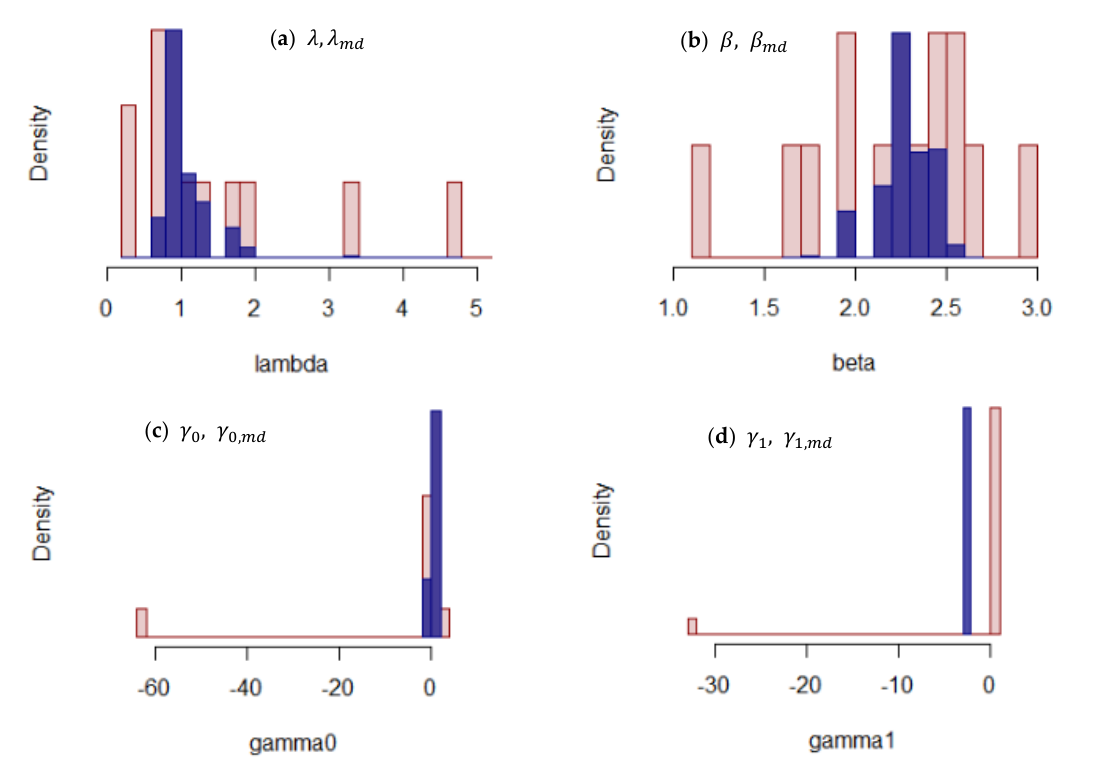
Figure 4. Distribution of the estimated model parameters for each module (red) and model parameter medians ( λ md , β md , γ 0, md , γ 1, md ) estimated by 10,000 bootstraps (blue).